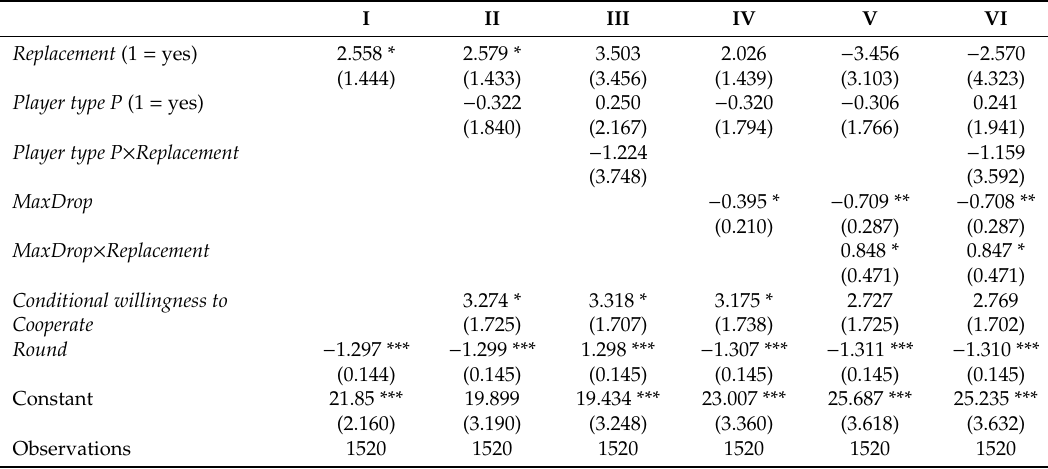
Table 8. Tobit estimations on individual contributions in part II ( Exo ).